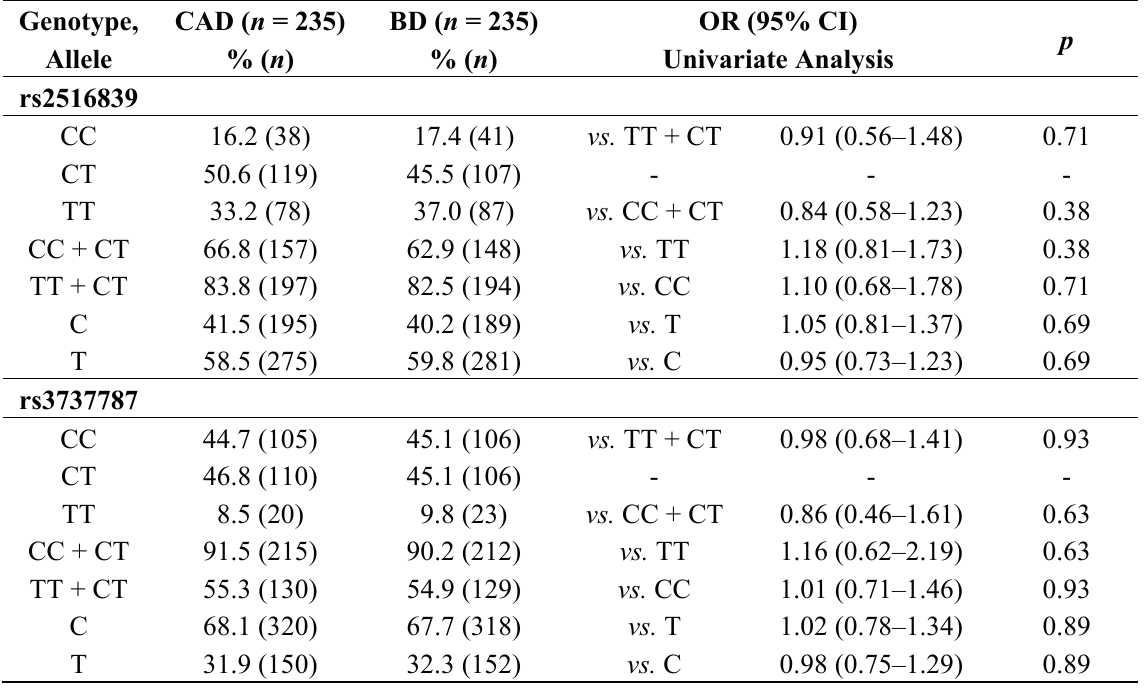
Table 2. The frequency of genotypes and alleles of the USF1 gene polymorphisms in the groups of coronary artery disease (CAD) patients and blood donors.